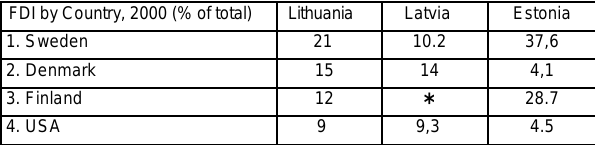
Table 2. Composition of FDI by countries [14], [15], [16] FDI by Country, 2000 (% of